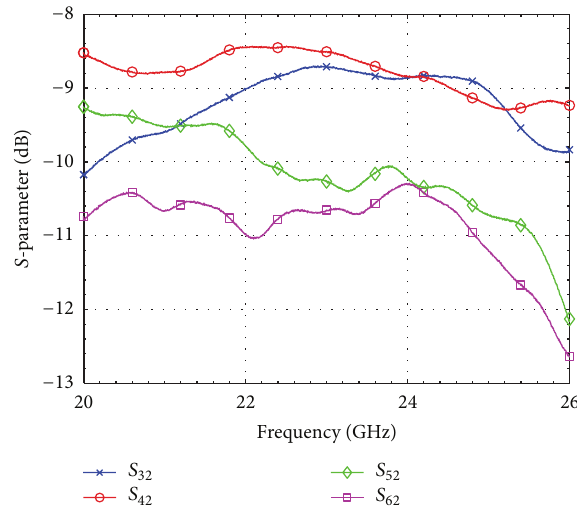
Figure 17: Six-port: measured transmission from port 2 to the output ports.